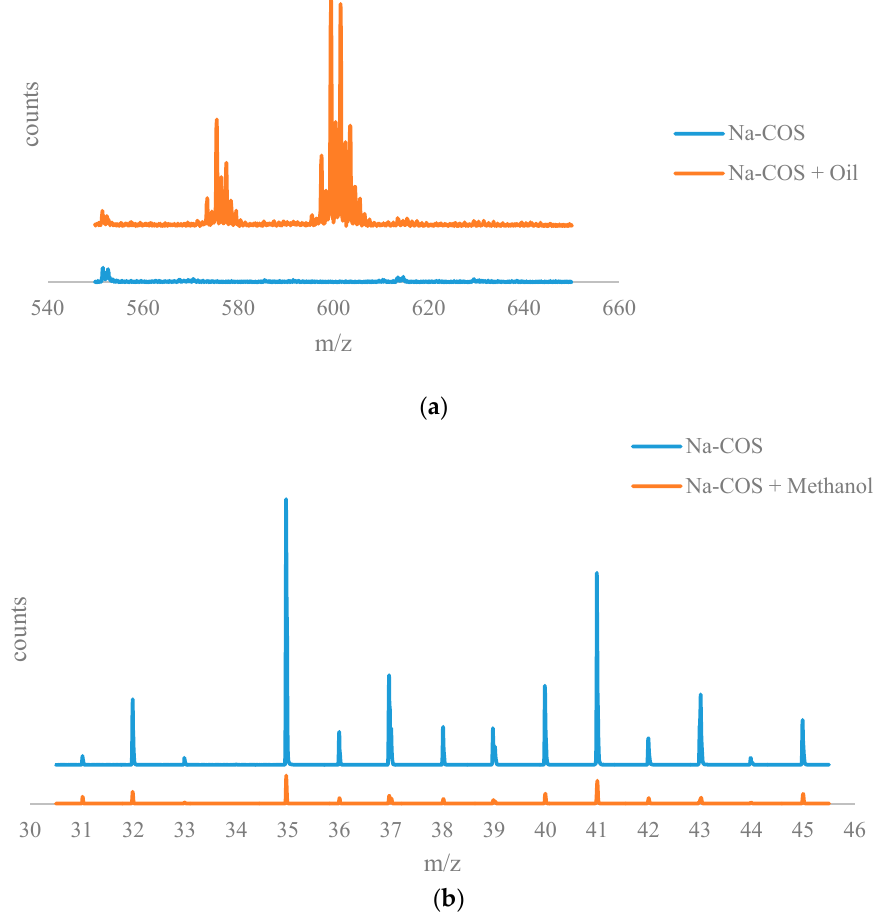
Figure 6. The results from the time of flight secondary ion mass spectrometry (TOF-SIMS) analysis: ( a ) TOF-SIMS spectra of the positive ions of Na-COS ( bottom ) and oil-soaked Na-COS ( top ); ( b ) TOF-SIMS patterns of the negative ions of Na-COS ( top ) and methanol-soaked Na-COS ( bottom ).